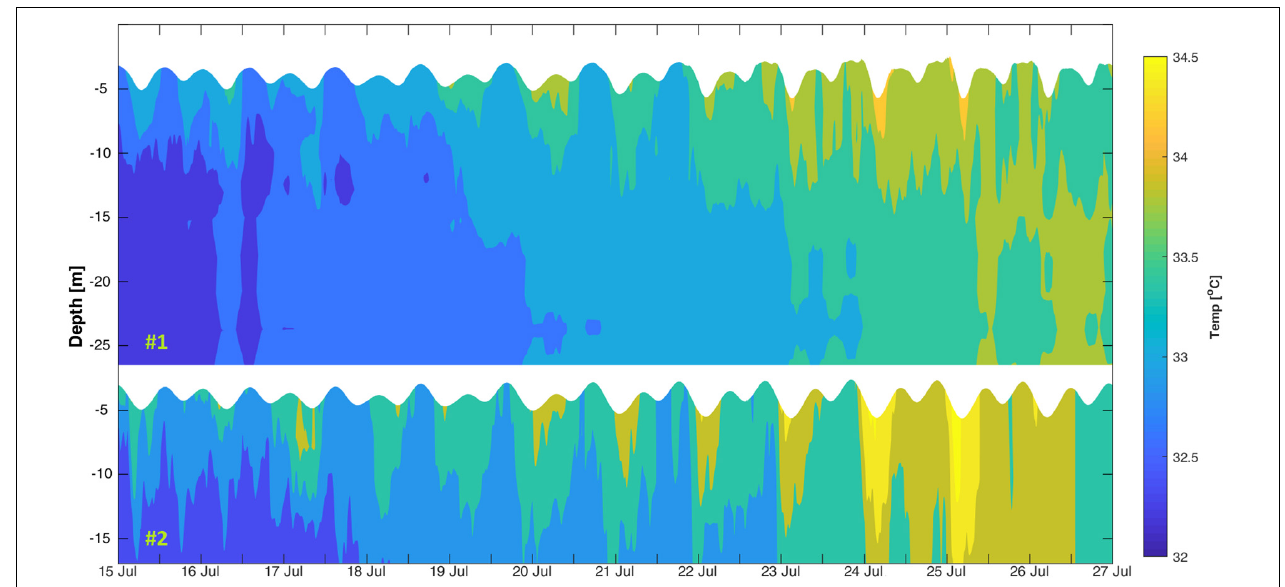
FIGURE 2 | Vertical thermal structure between 15 and 27 July 2017 at #1 (top) and #2 (bottom)